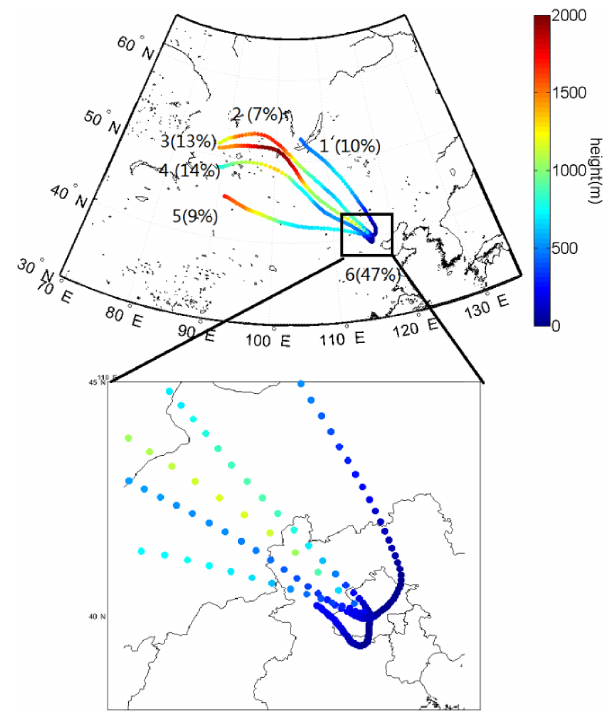
Figure 2. The 3-day backward trajectory of air parcels during the observation period; the colors of air trajectories represent height during